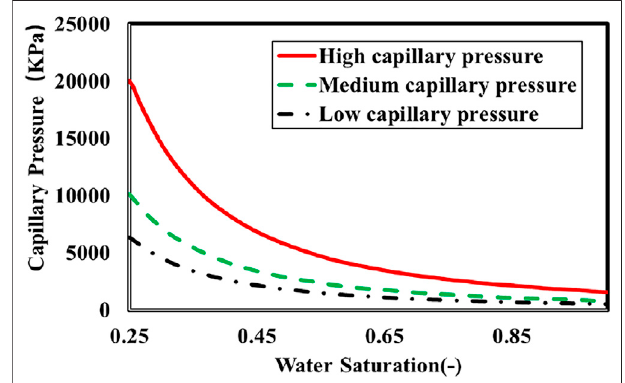
FIGURE 10 | Changing curves of the cumulative gas production after 10-day shut-in and 3-year production for different reservoir wettability degrees.